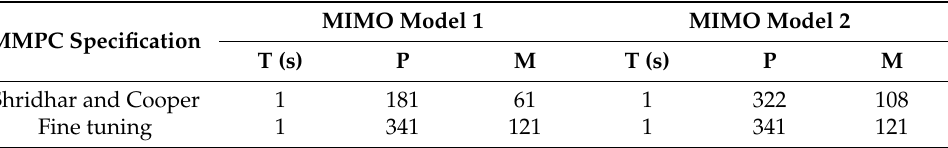
Table 5. MMPC parameters on the compression